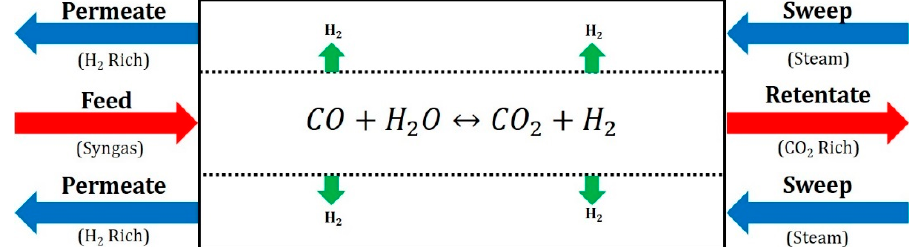
Figure 1. Schematic of the polymer membrane which consists of a tube packed with catalyst surrounded by a polymer membrane to allow simultaneous reaction and permeation.